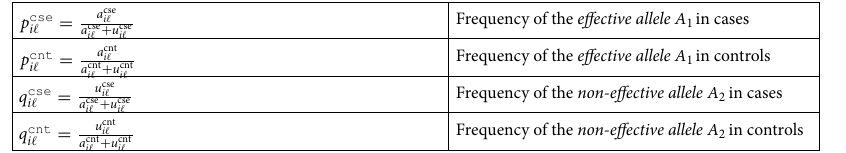
Table 9. Notations and definitions of (effective or non-effective) allele frequencies in cases and controls. The subscripts i and ℓ indicate SNP number and study number, respectively.